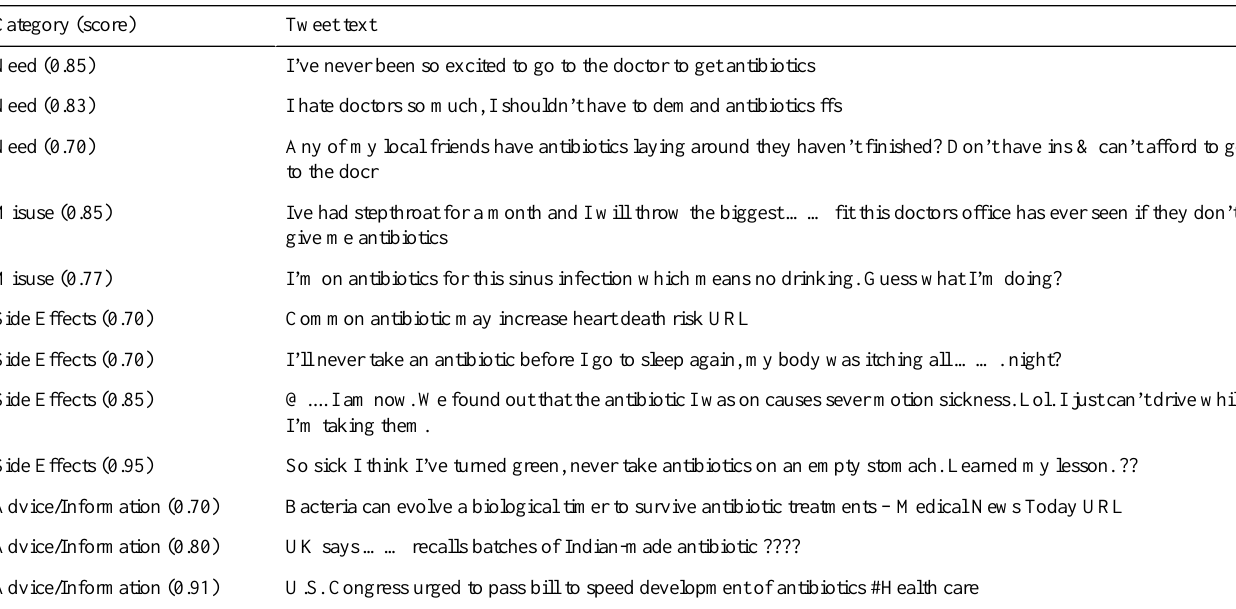
Table 5. Sample tweets that were discovered through the trained classifier: tweet text, predicted category, and score. Tweet textCategory